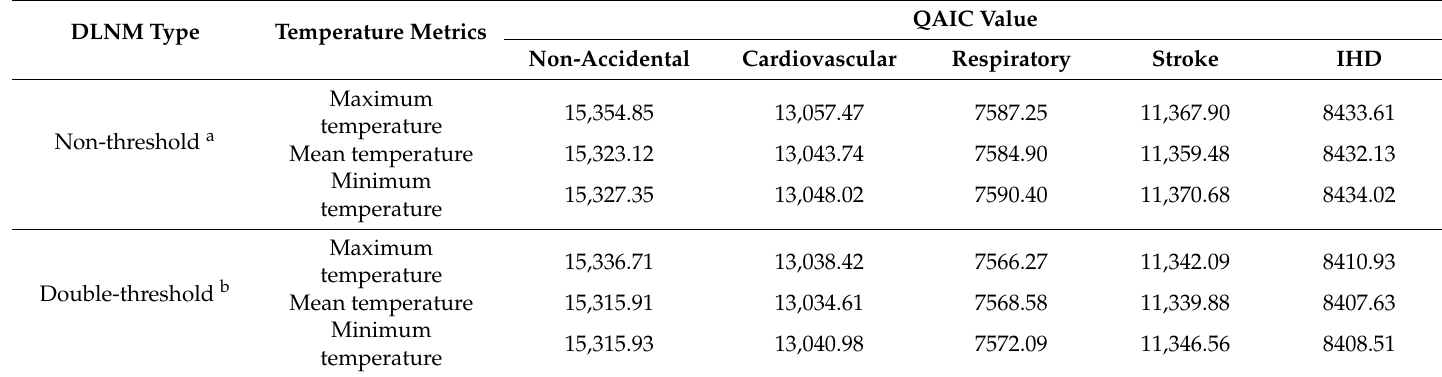
Table 3. Akaike information criteria (QAIC) values of non-threshold and double-threshold DLNM models predicted by different temperature metrics.